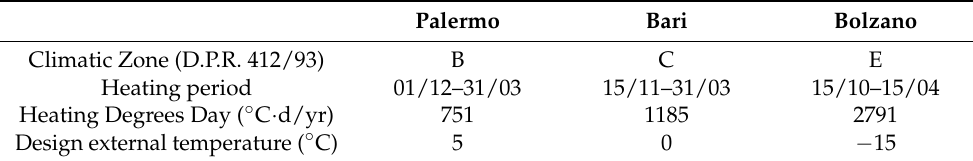
Table 6. Site climatic properties (Italian